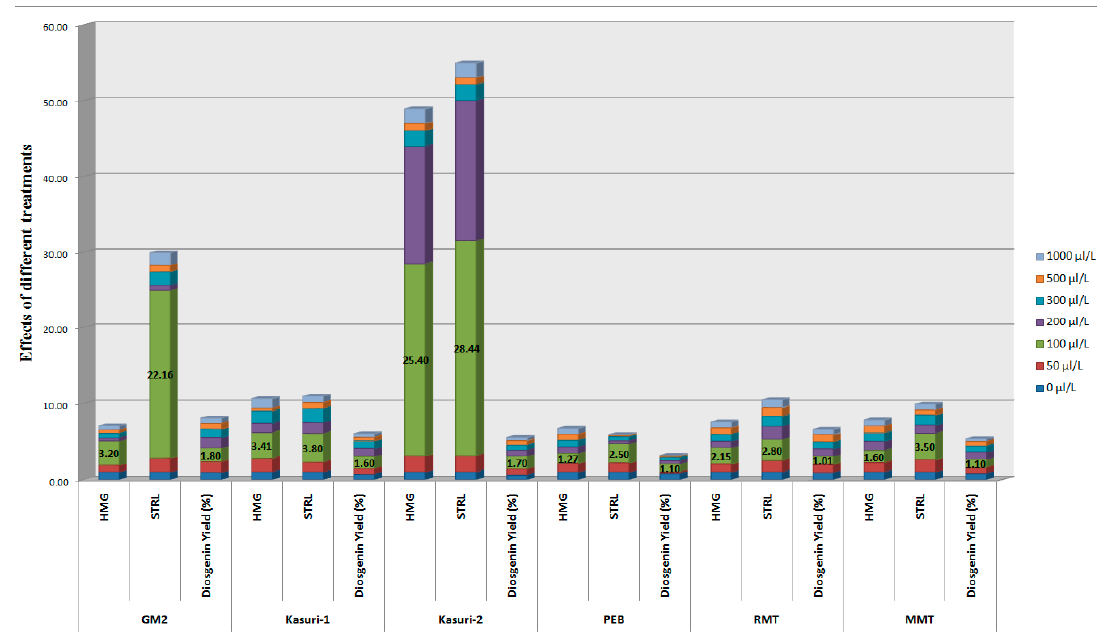
Figure 2. Effects of methyl jasmonate (MeJA) treatments on the expression of 3-hydroxy-3-methylglutaryl-CoA reductase ( HMG ) and sterol-3- β -glucosyl transferase ( STRL ) genes and diosgenin yield (%) in fenugreek ( Trigonella foeum-graecum L.) plants (as per data reported in Supplementary Table S1). Table 3. Effect of methyl jasmonate (MeJA) treatments on the length (cm) of seedlings of different fenugreek ( Trigonella foeum-graecum L.) varieties. Fenugreek Varieties